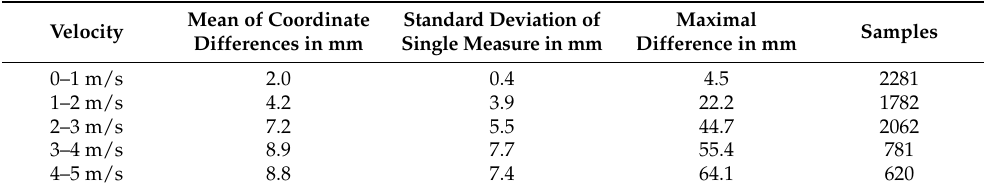
Table 3. Coordinate differences dependent on the velocity.